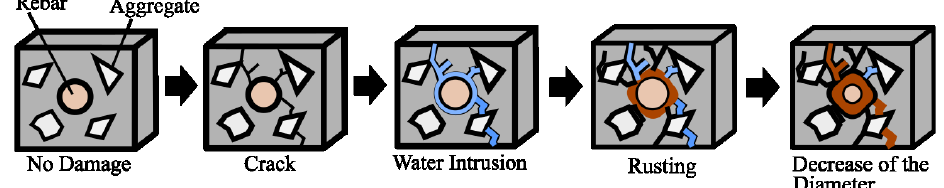
Figure 1. Typical corrosion process of reinforced